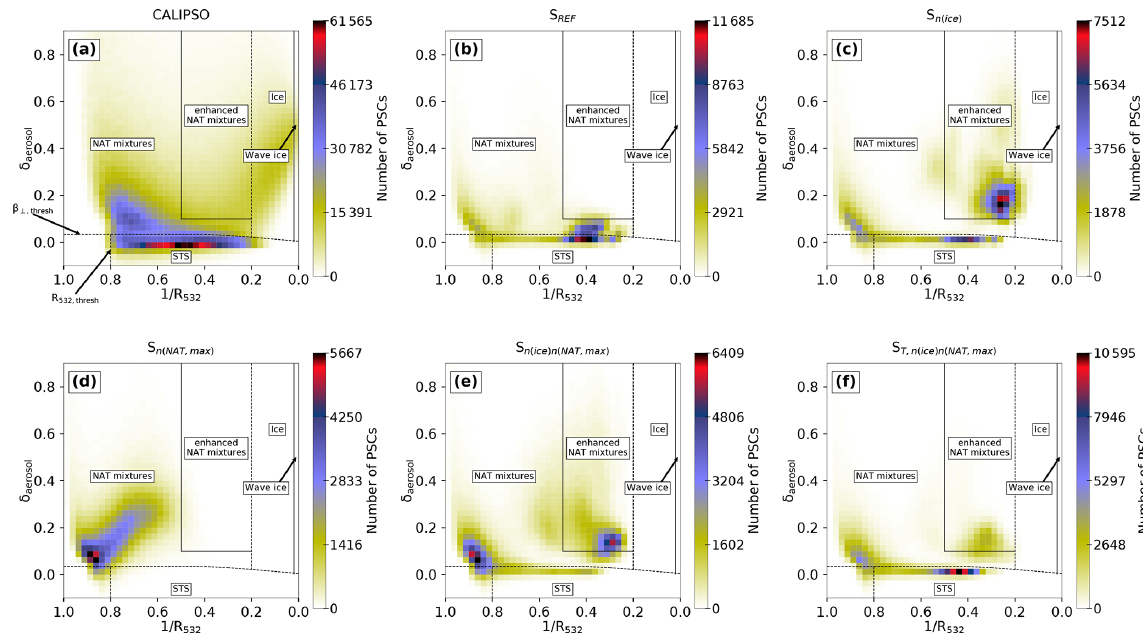
Figure A8. As Fig. A7, but for the year